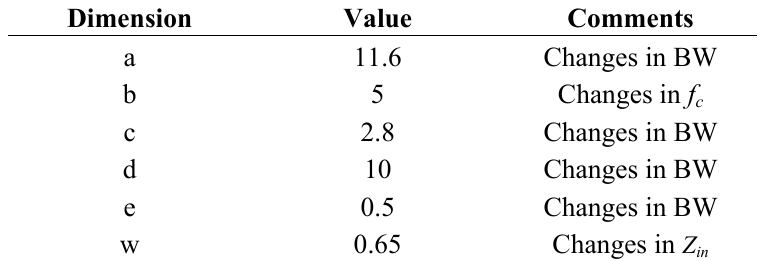
) and input impedance ( Z ). c in